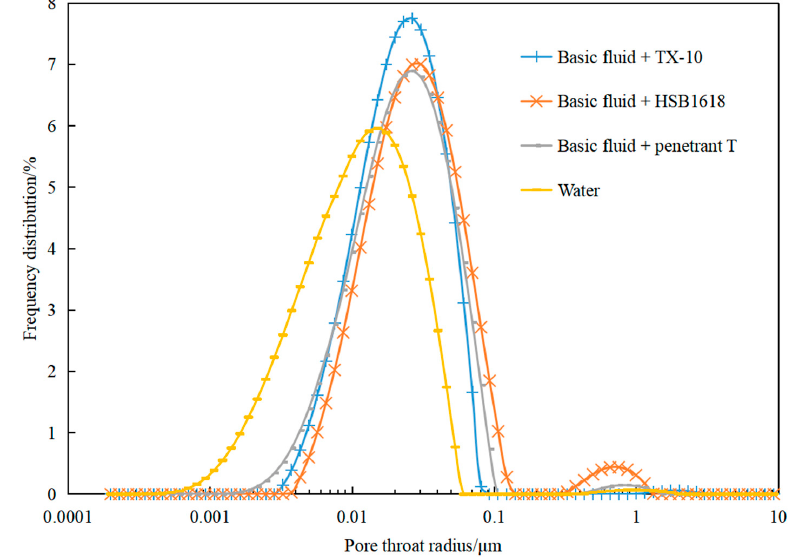
ff erent drilling